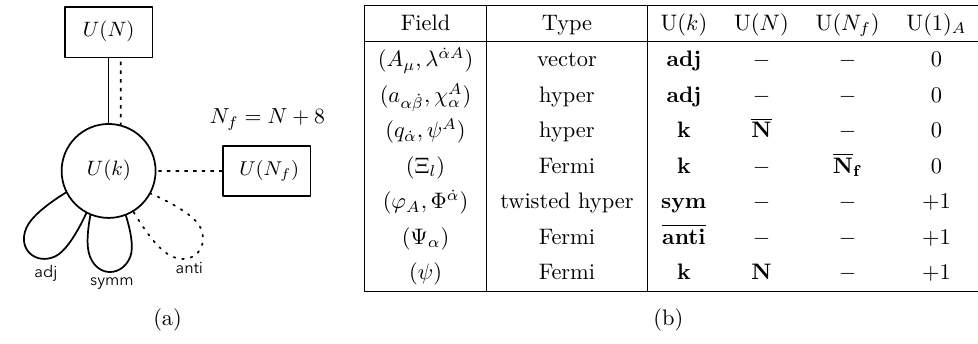
decomposed into Q αA